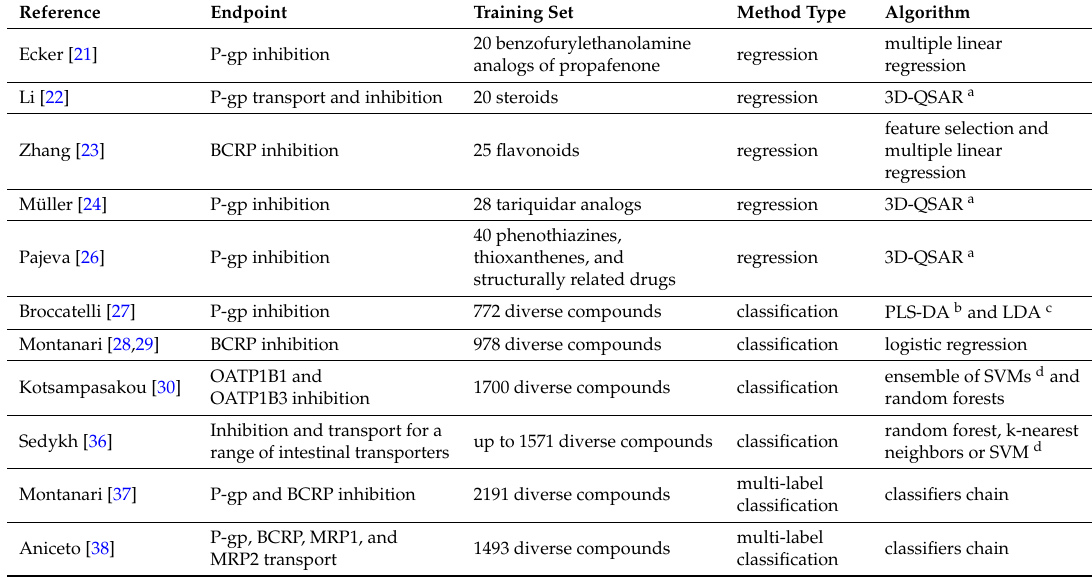
Table 1. Summary of the methods used to predict ligand–transporter